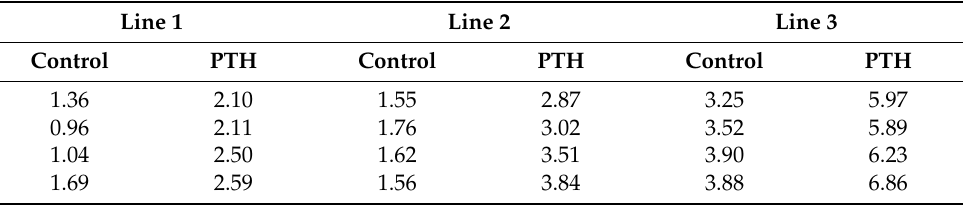
Table 2. Individual data points of MHC protein quantification in each hSC line differentiated in